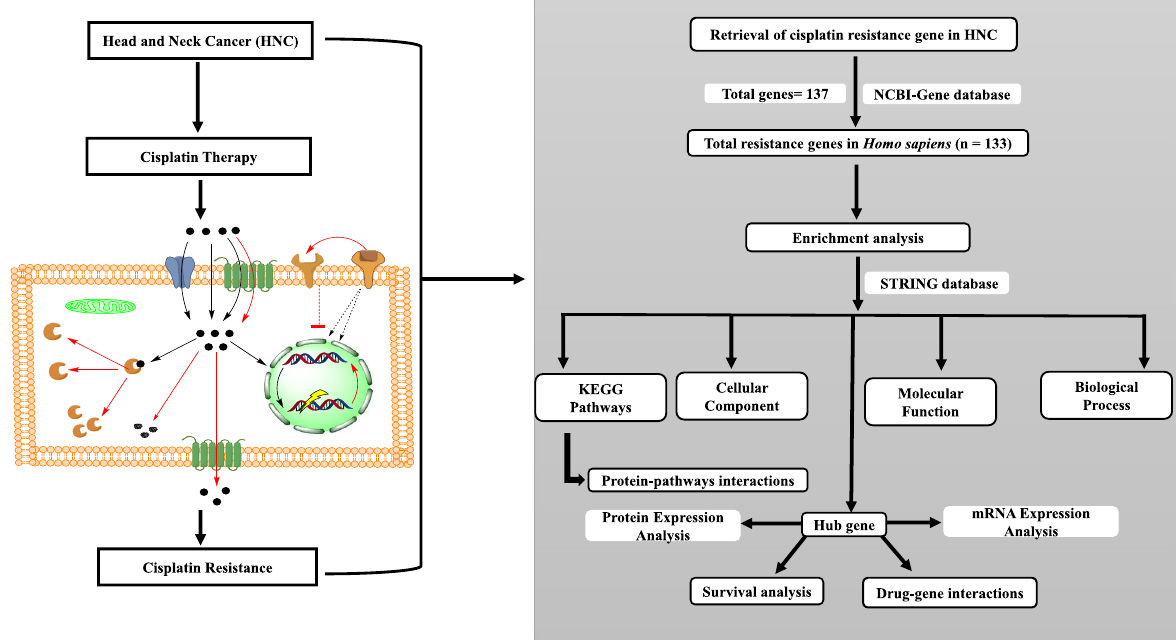
Fig. 1 Workflow for the identification of hub genes involved in cisplatin